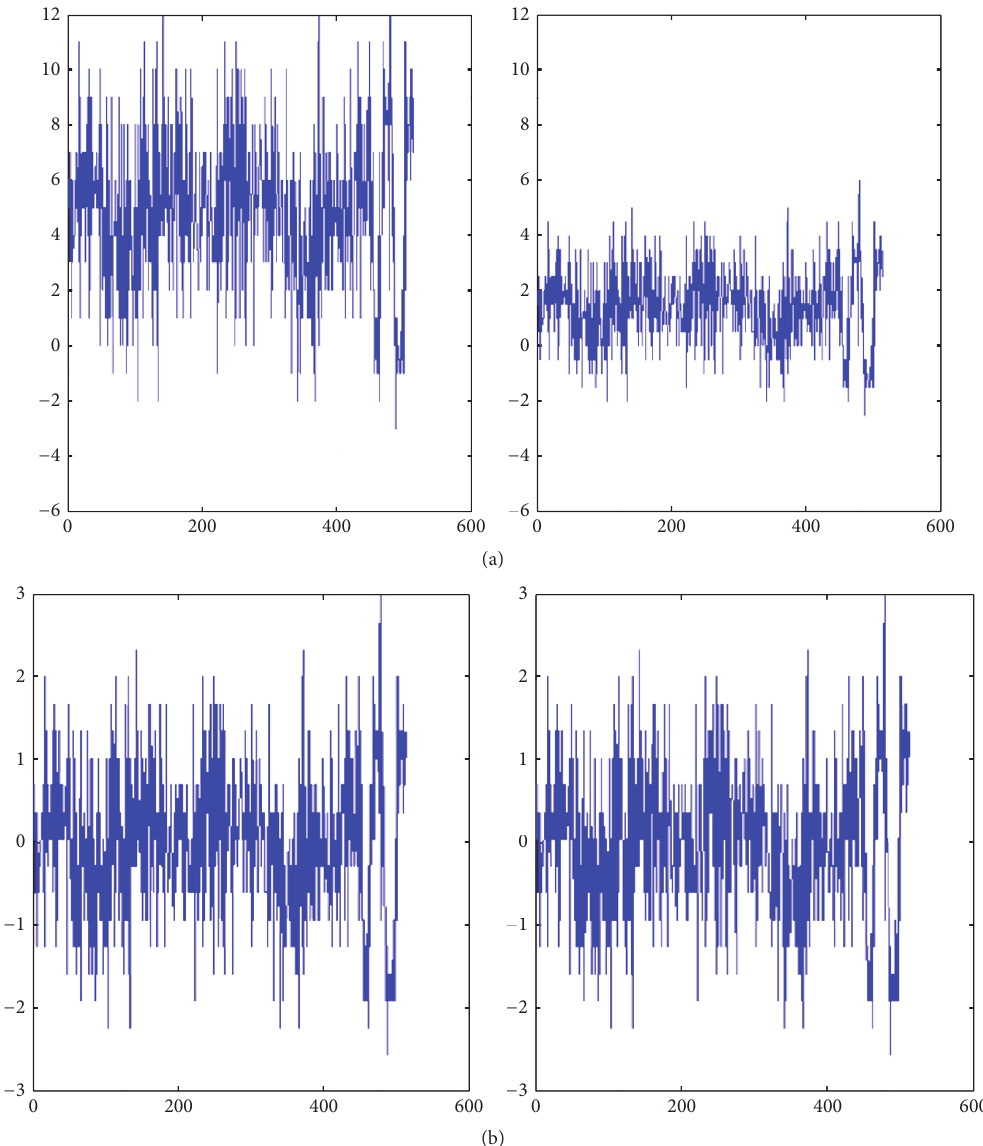
Figure 3: (a) Two speech signals that have different sound volume before normalization. (b) Two speech signals that have different sound volume after